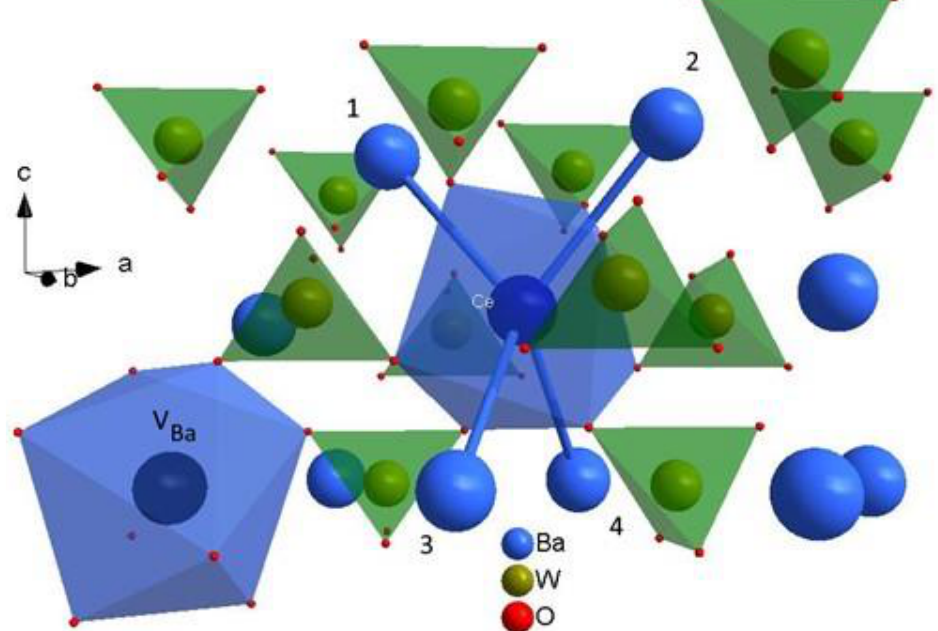
Figure 3. Part of the unit cell structure of a BaWO 4 single crystal with marked [CeBa 4 ] tetrahedron (1 – 4 Ba 2+ ions and Ce 3+ ion in the middle). The cerium dodecahedron [CeO 8 ], the barium vacancy dodecahedron [V Ba O 8 ], and tungstate tetrahedrons [WO 4 ] are also shown.